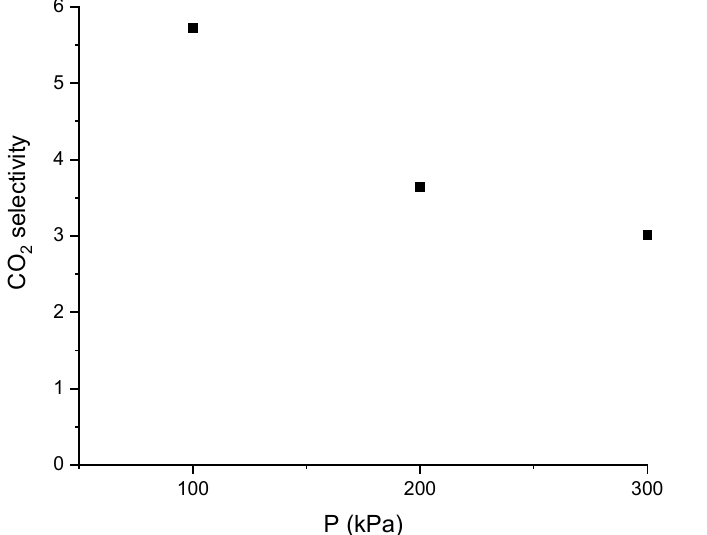
Figure 19. CO 2 selectivity based on the absorption of pure gases by ChCl:LvAc (1:3:2.5) at 25 °C and 250 rpm.